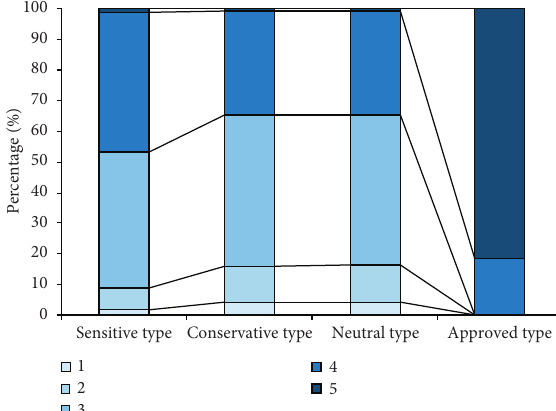
Figure 4: EE of drivers in the four segments.